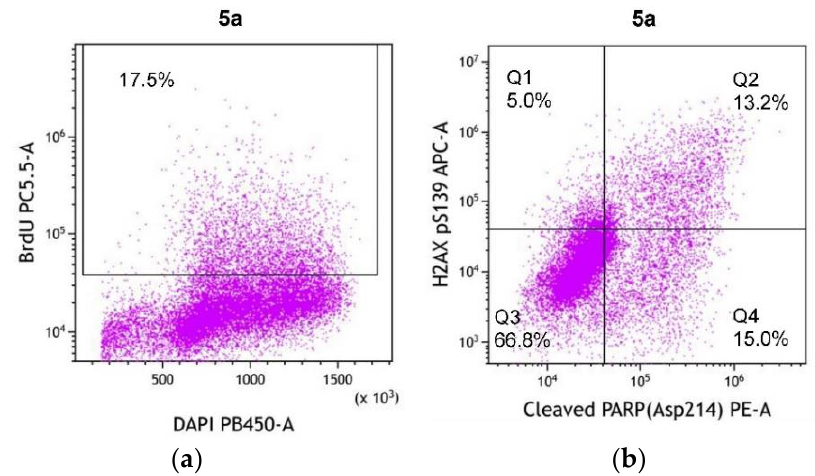
Figure 3. Representative scattered blots of multiparameter flow cytometry analysis of cell proliferation, DNA damage and apoptosis in HL-60 cells treated with 5a (1.8µM) for 24 h. Panel ( a ): DAPI vs. BrdU PerCP-Cy.5.5 staining profile. BrdU positive cells are in the inside frame. Panel ( b ): cleaved PARP (Asp214) PE vs. H2AX (pS139) Alexa profile. Squares Q1 + Q2 represent H2AX (pS139) Alexa positive cells, squares Q2 + Q4 represent cleaved PARP (Asp214) PE positive cells, whereas square Q3 represents H2AX (pS139) Alexa and cleaved PARP (Asp214) PE negative cells. BrdU is an analog of thymidine, and its incorporation into DNA was used as an index of cell proliferation. 5a dose-dependently inhibited cell proliferation. At 1.8 µ M concentration, this analog caused a 2.2-fold decrease in BrdU incorporation (Figure 4a).